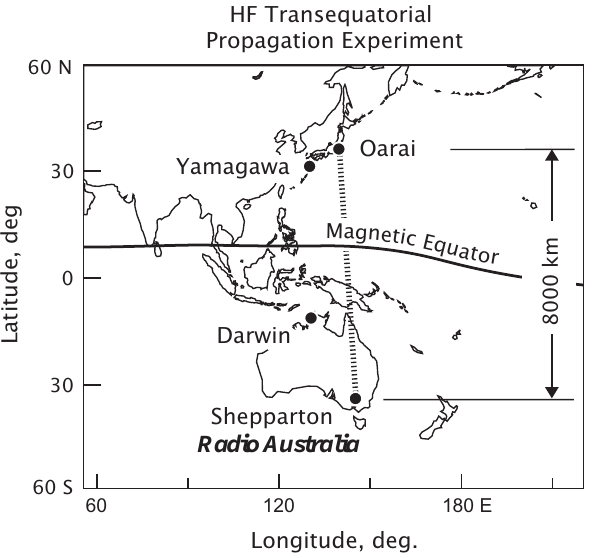
Fig. 1. Geometry of the HF transequatorial propagation experiment between Shepparton, Australia and Oarai, Japan. A VHF transe- quatorial propagation experiment between Darwin and Yamagawa was reported in 1980.